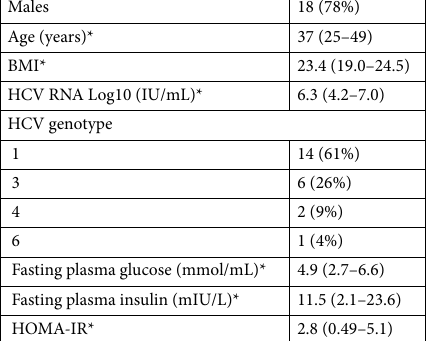
Table 1. Baseline characteristics of 23 chronic hepatitis C patients. *Data reported as median values